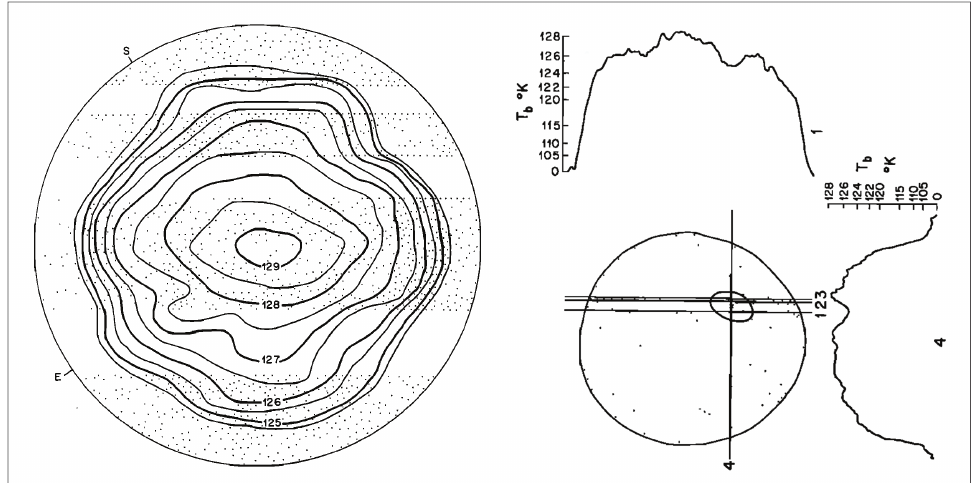
Figure 6. Among the earliest maps of Jupiter’s mid-infrared radiances, reproduced from Murray et al. [129]. Left: Contours show brightness temperatures derived from 8 to 14 µ m ob- servations, made over five nights in mid-December 1963 using the Hale 200-inch (5.1 m) Telescope of the Palomar Observatory. The contours indicate modest limb-darkening and early hints of possible zonal thermal structure, with the visible belt-zone structure superimposed (oriented south pole upwards). Right: Perpendicular lines represent scans passing through the Great Red Spot (GRS). Corresponding brightness temperature curves (as numbered just to the right and above) show a depression in temperature at the location of the